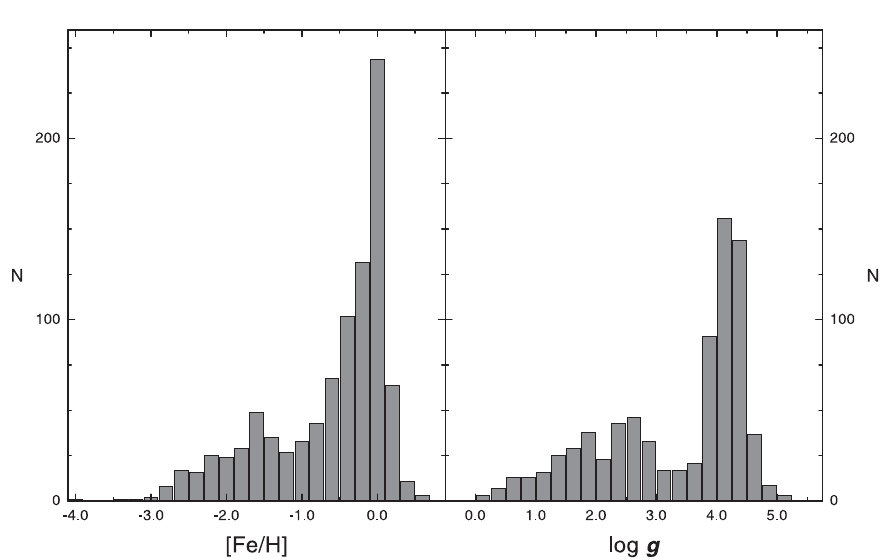
Fig. 1. Distribution of stars in the sample by metallicity (left) and gravity (right).